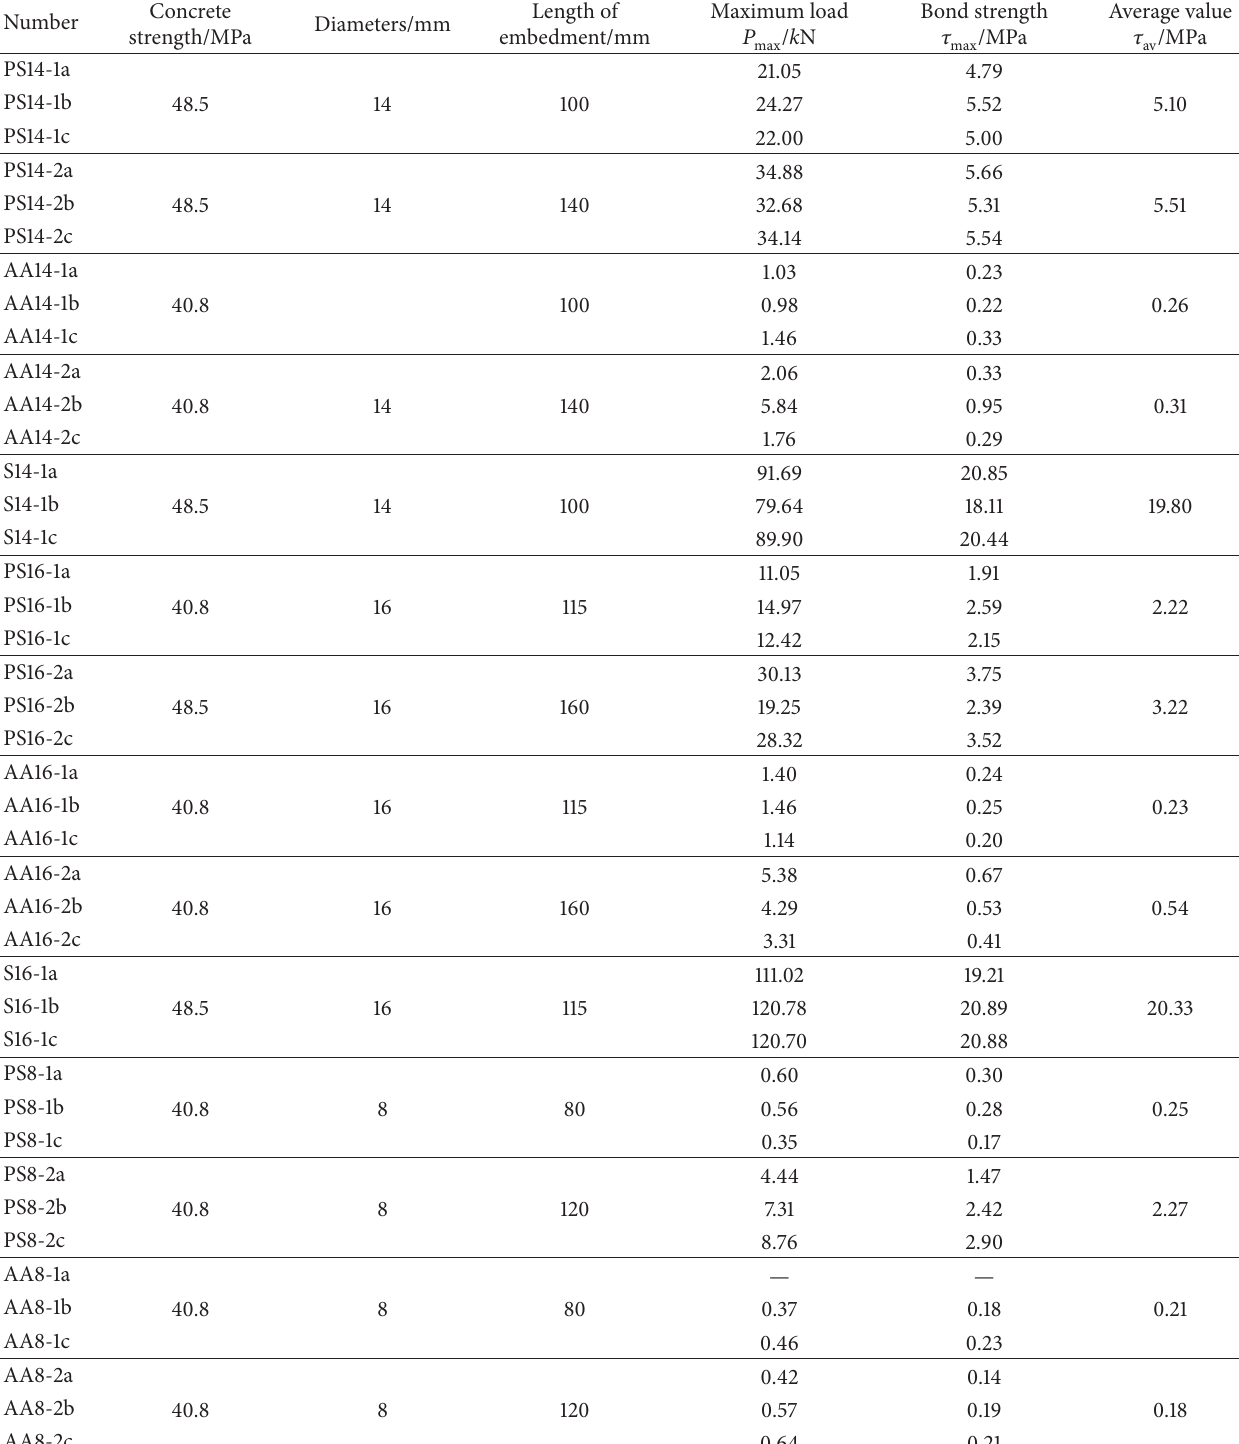
Table 3: Main test